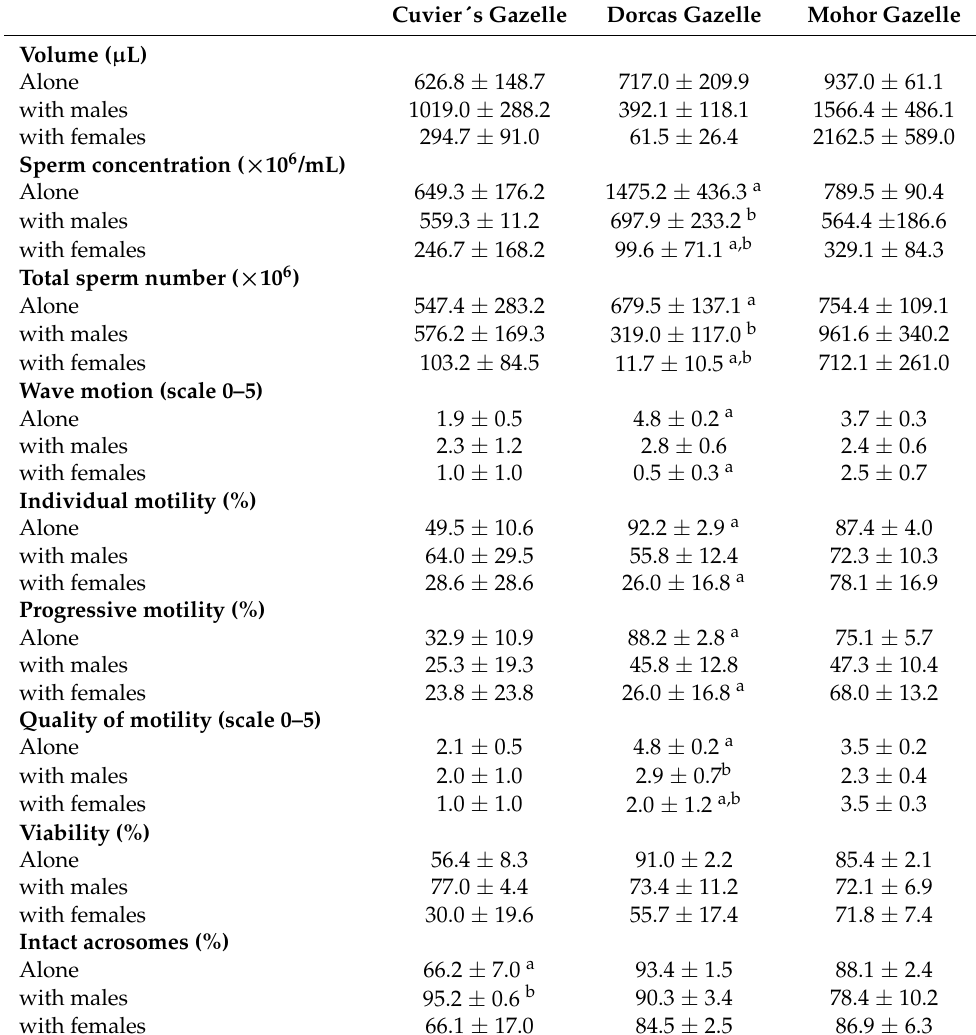
Table 2. Semen parameters in males of three species of gazelles housed alone, with males or with